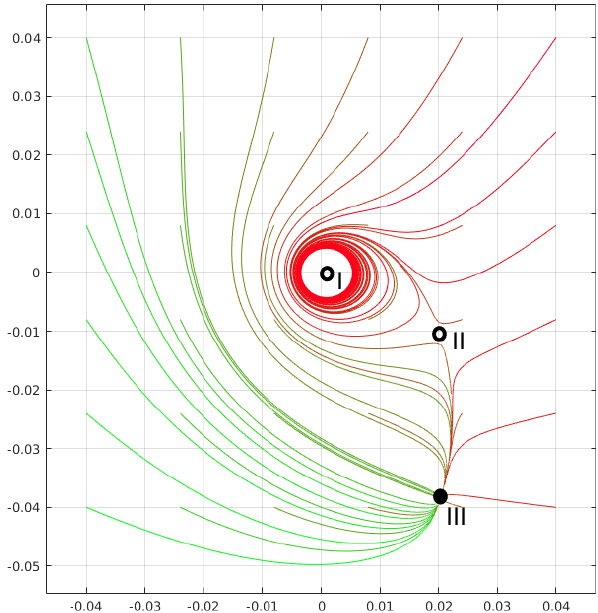
Figure 4. Example illustration of monodisperse droplets’ trajecto- ries in 2-D space (projection on a plane perpendicular to the vor- tex axis) with zero initial velocity. Particle trajectories (color lines) show the presence of three equilibrium points marked with black dots: I – unstable near vortex axis; II – unstable middle distance point; III – stable point far from the axis. Some droplets rotate around the vortex core on various orbits; some of these orbits may correspond to limit cycles. Different attraction regions can be no-